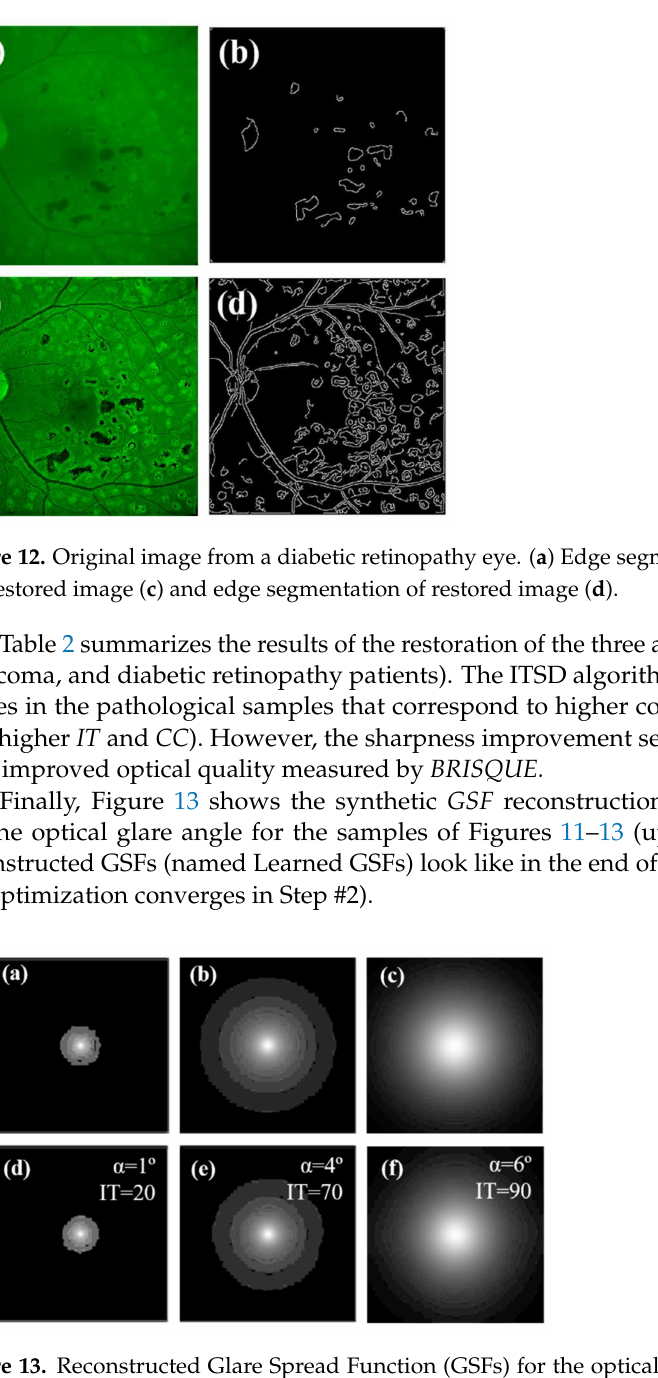
Figure 13. Reconstructed Glare Spread Function (GSFs) for the optical α values found in Step #1 for the healthy ( a ), glaucoma ( b ), and diabetic retinopathy ( c ) samples and generated GSFs after the optimization converges (optimal iteration number in Step #2) ( d – f